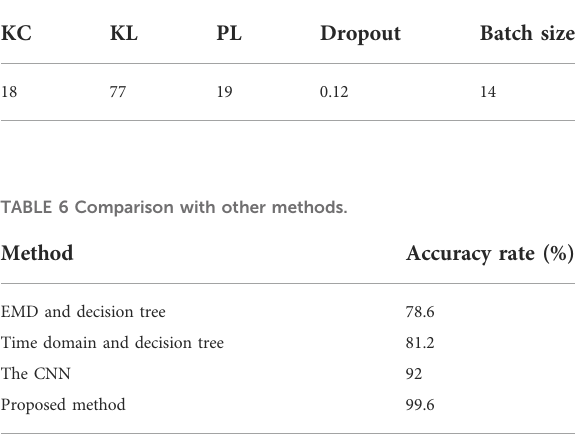
TABLE 5 The hyper parameters of the CNN.